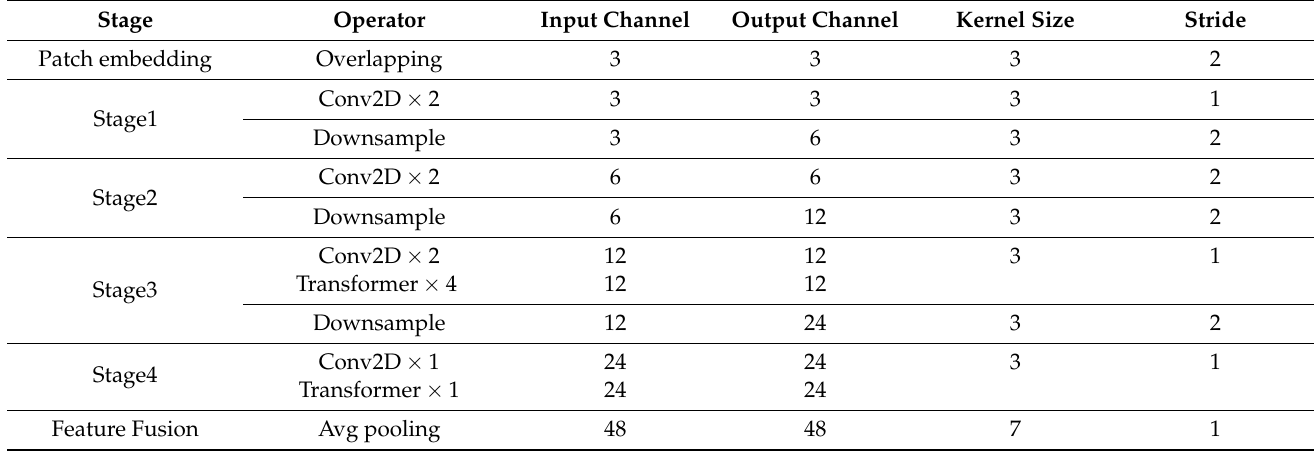
Table 2. Parameter setting of each block in the model.